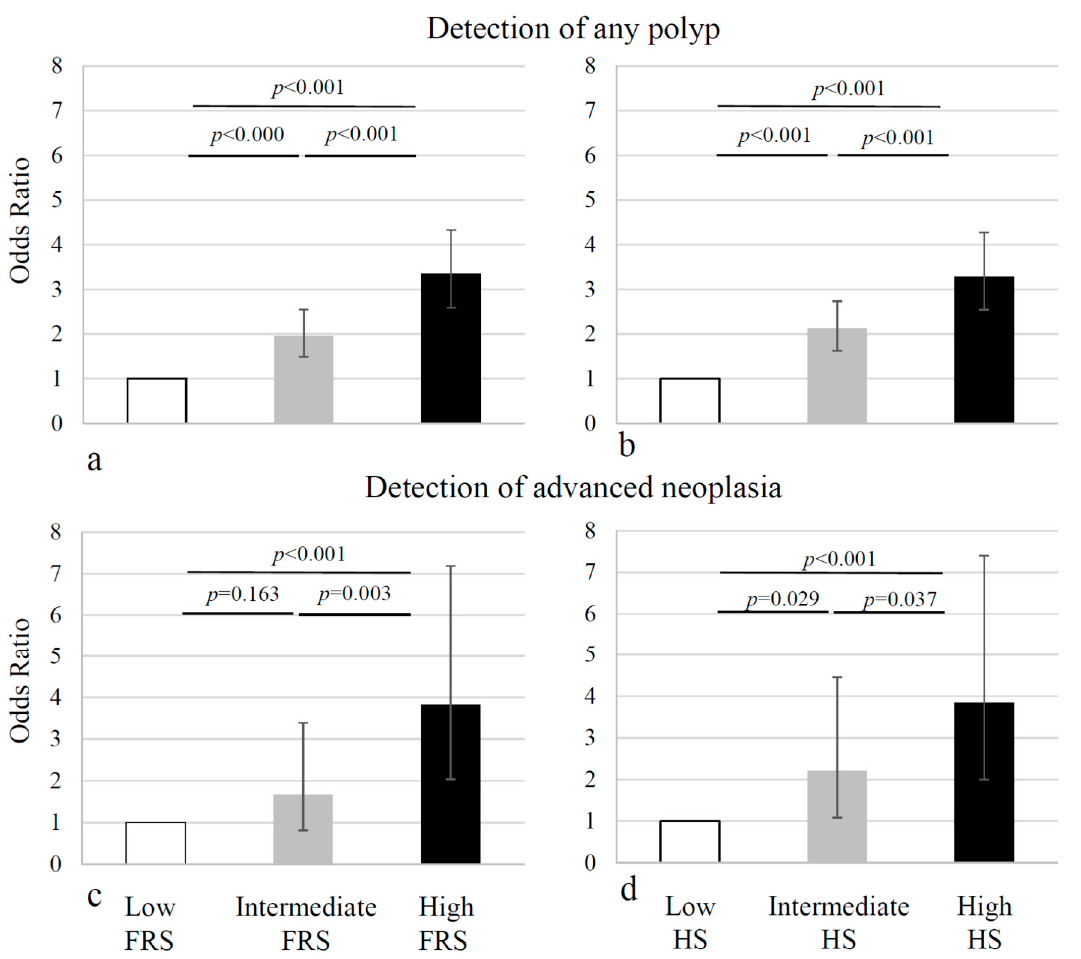
Figure 1. Odds ratios for any adenoma and advanced neoplasia. The odds ratios (ORs) for the prevalence of any adenoma, more than doubled in the Framingham Risk Score (FRS) and the Heart Score (HS) of the European Society of Cardiology intermediate tertiles, and tripled in the upper FRS and HS tertiles, relative to the respective low tertiles ( a , b ). ORs for having advanced neoplasia only marginally increased in the intermediate tertiles, but showed a more than three-fold increase in the upper tertiles of the FRS and the HS ( c , d ).